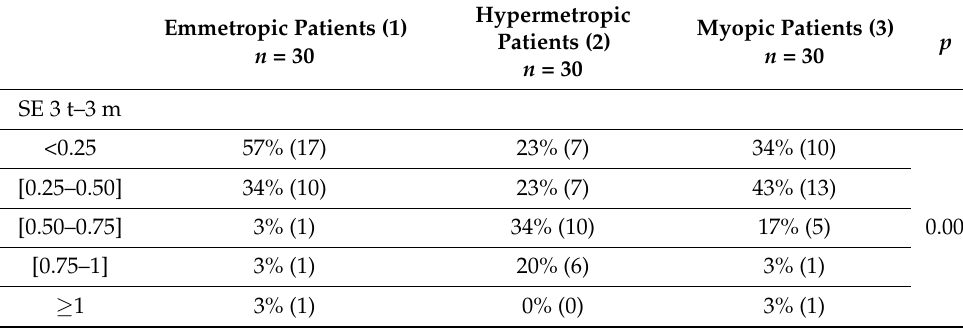
Table 5. Characteristics of the analysed groups in terms of the SE changes (3 t–3